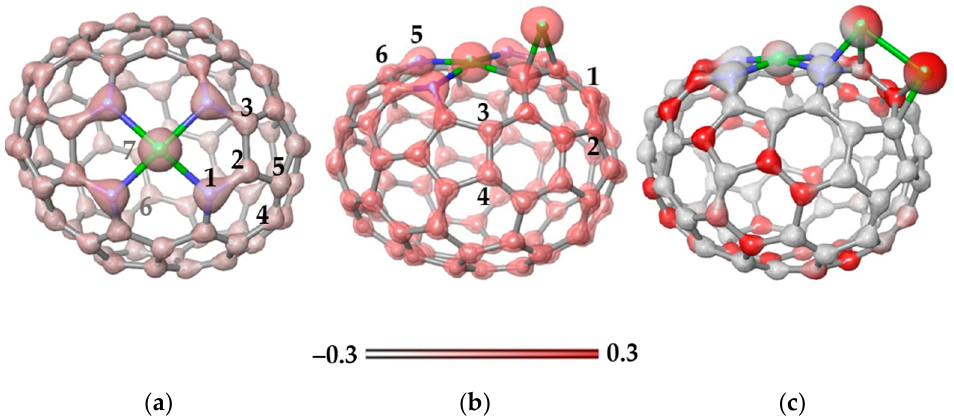
Figure 8. Electron density maps (iso-value of 0.3 kcal mol –1 ) plotted for ( a ) the Ni-N 4 C 78 model and energetically preferable configurations of this model with ( b ) one attached Ni atom and ( c ) two attached Ni atoms. Optimized structures correspond to the ground state (triplet) of the models. N and Ni atoms are shown by blue and green balls, respectively. The numbers in ( a ) and ( b ) indicate the positions to add the next Ni atom. The energy gain from Ni atom addition is 1.914 eV for structure ( b ) and 2.100 eV for structure ( c ). The scale corresponds to the electrostatic potential.